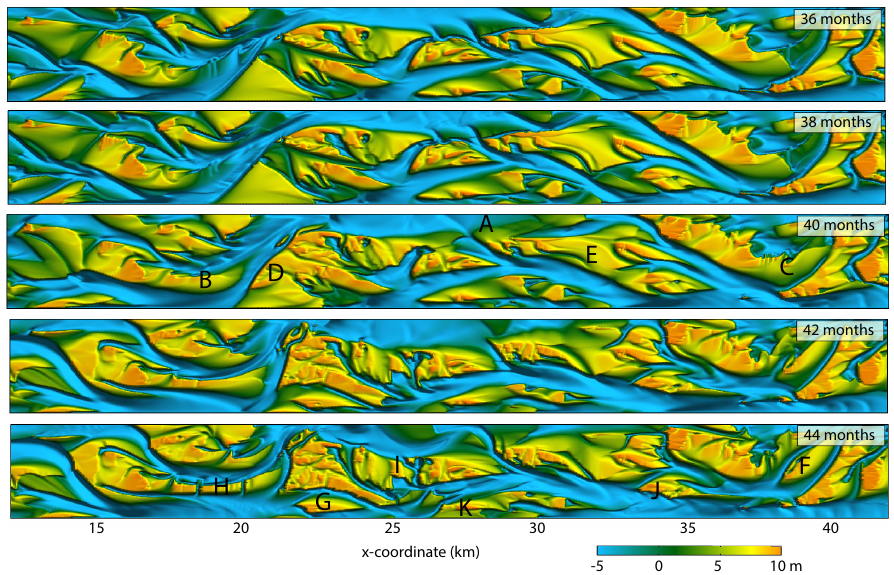
Figure 5. Detail of short-term bar and branch dynamics in the case of a hydrograph and fixed channel walls, starting from low discharge in month 36 and continuing to the peak discharge in month 40 and a declining discharge